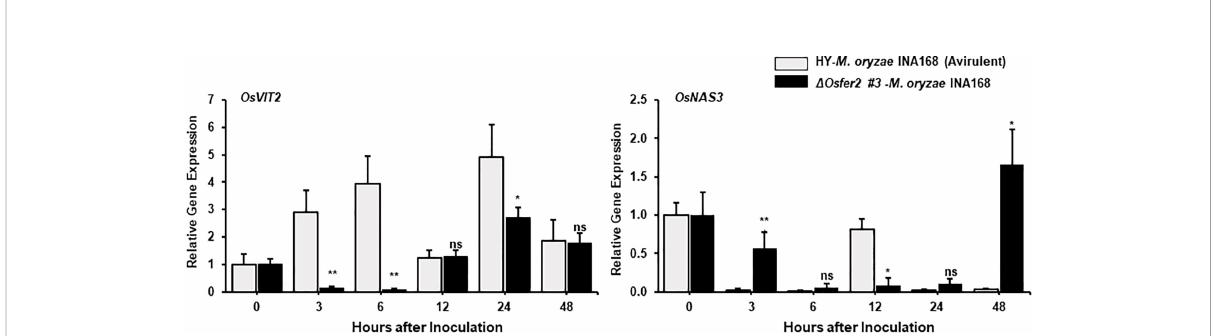
FIGURE 7 Quantitative real-time RT-PCR analysis of time-course expression of iron regulation genes in rice HY and D Osfer2 mutant plants during avirulent Magnaporthe oryzae INA168 infection. Expression of rice iron regulation genes such as vacuolar Fe transporter 2 ( OsVIT2 ) and NA synthase 3 ( OsNAS3 ) were analyzed by qRT-PCR. Relative expression levels in rice leaf sheaths were calculated using the corresponding values at 0 hpi (control) after normalizing with respect to the expression of the internal control OsUbiquitin. Asterisks indicate statistically signi fi cant differences (Student ’ s t -test, * P <0.05 and ** P <0.01). ns, not signi fi